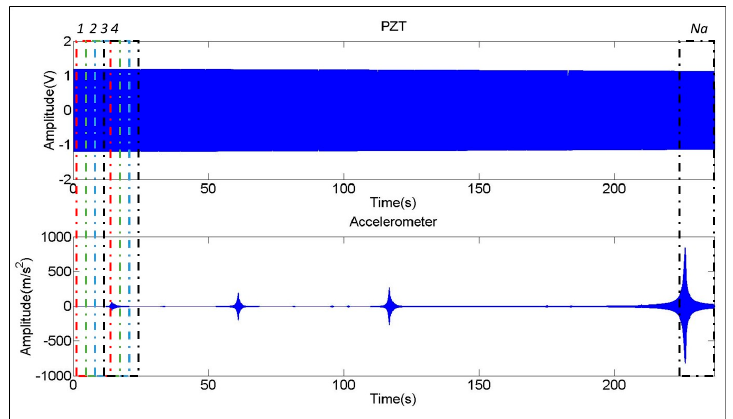
Figure 4. Sweep excitation (PZT): excitation and response.